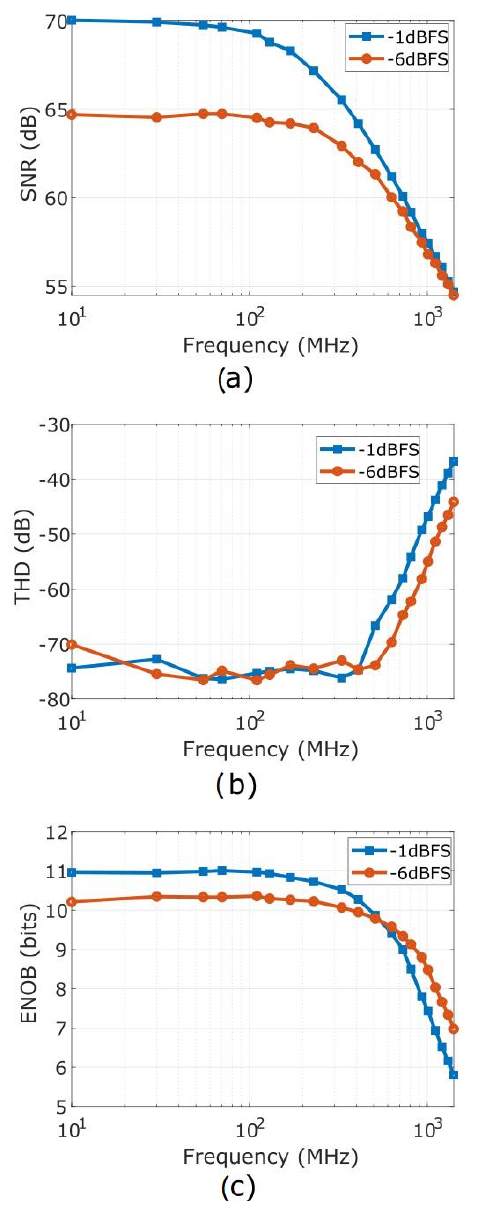
Figure 7. Metrological characterization of the RF detector at input amplitudes of –1 and –6 dBFS: ( a ) signal-to-noise ratio; ( b ) total harmonic distortion; ( c ) effective number of